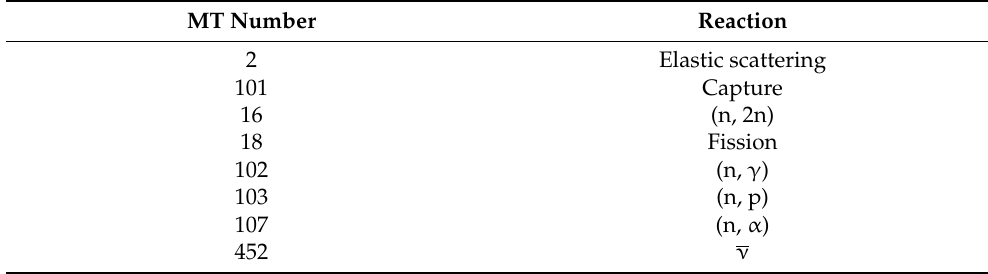
Table 3. Reaction type corresponding to MT